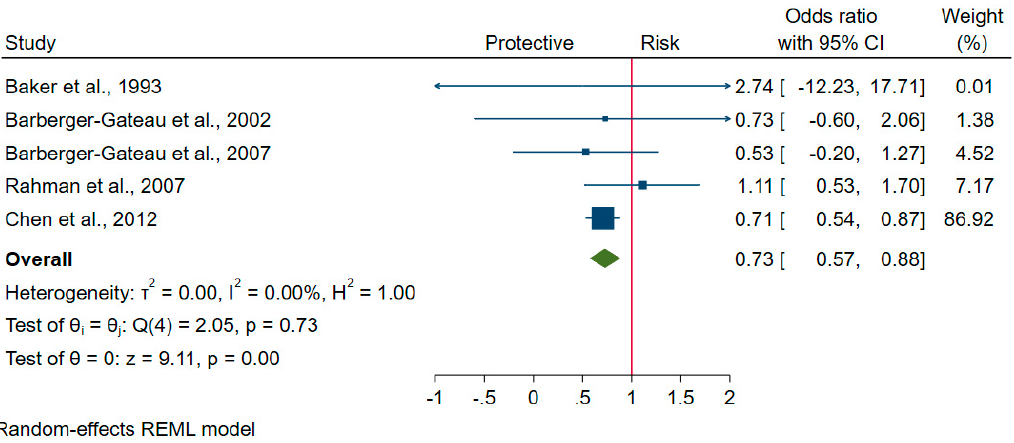
Figure 3. Forest plot of studies reporting odds ratios of those who consumed meat (fish not included) weekly or more (‘always’) vs. less frequently (‘not always’) in cases diagnosed with cognitive disorders compared to controls.